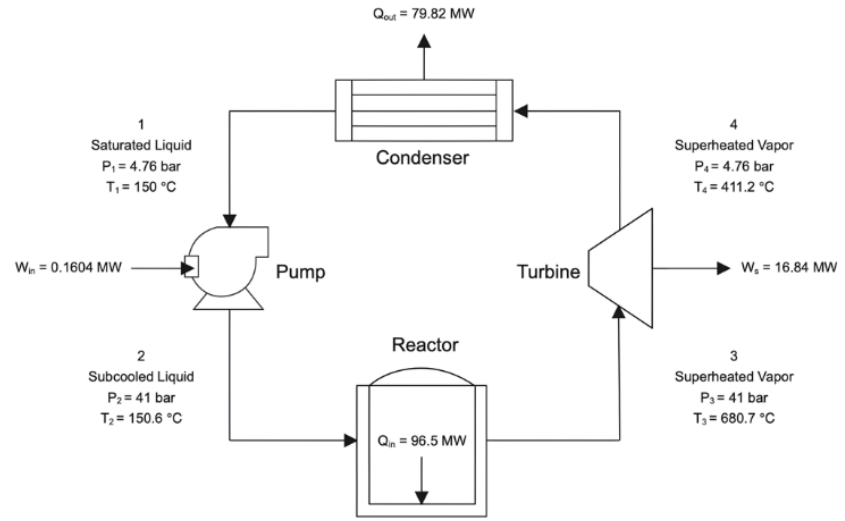
Figure 10. Power production cycle coupled with the OCM reactor jacket.